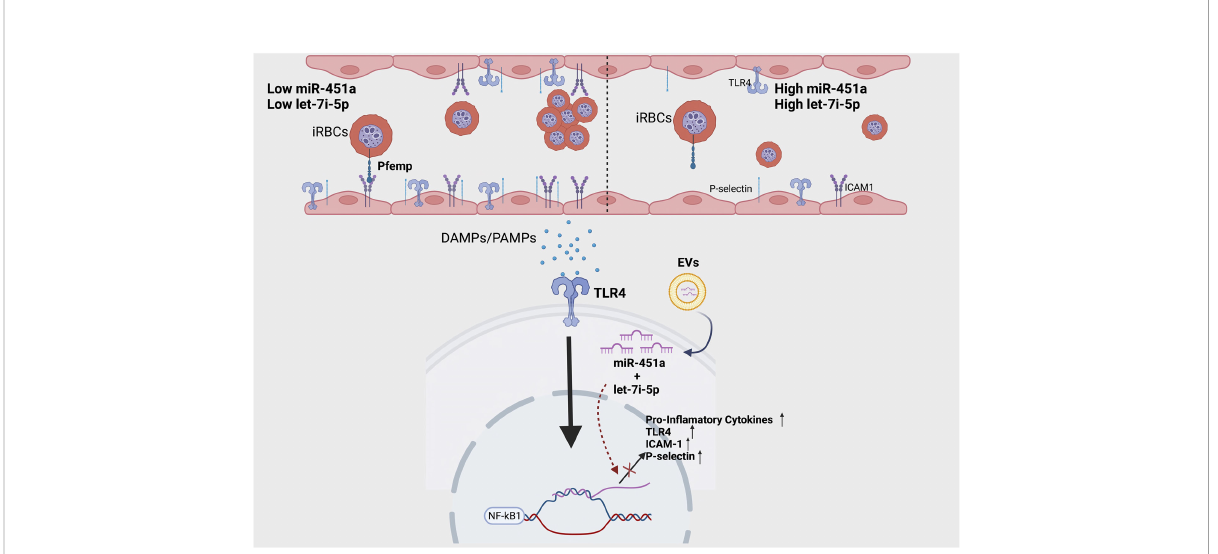
FIGURE 4 Proposed model of molecular signi fi cance of miR-451a and let-7i-5p loaded EVs in hemolytic induced in fl ammation via malaria infection. Patients with low circulating miR-451a or let-7i-5p loaded EVs have increased in fl ammatory cytokines release and increased expression of adhesion molecules. This increases the likelihood of iRBC stasis via the binding of malaria-speci fi c ligand Pfempf1. Damage Associated Molecular Patterns (DAMPs), such as free-heme, and Pathogen Associated Molecular Patterns (PAMPs) activate TLR4 receptor inducing NF k К - b transcription factor signaling. MiR-451a and let-7i-5p inhibits the TLR4/NFK- b in fl ammatory cascade by decreasing mRNA transcription of TLR4, endothelial ligands, or pro-in fl ammatory cytokines. Image was created with